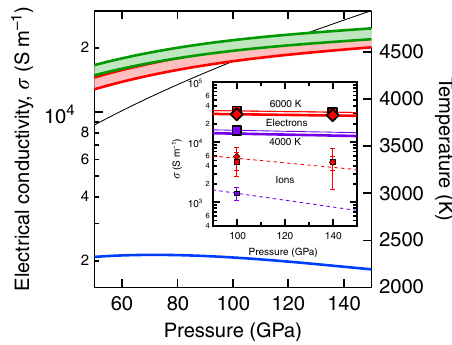
Fig. 1 Electrical conductivity. The electronic σ el (red), ionic σ ion (blue), and total σ total = σ el + σ ion (green) electrical conductivity along the magma ocean isentrope 37 (black) for low-spin (top of range shown) and high-spin (bottom of range) results. Along the magma ocean isentrope, the electrical conductivity increases with depth because the effects of increasing temperature outweigh the effects of increasing pressure. Inset. The electrical conductivity of the bulk silicate Earth liquid from our simulations, including the electronic (large symbols) and ionic (small symbols with 1 σ uncertanties) contributions at 6000 K (red) and 4000 K (purple) in spin- polarized (diamonds) and non-spin-polarized (squares) calculations. Lines are best fi ts to the form σ ¼ σ 0 T (cid:2) 1 exp (cid:2) E (cid:3) þ PV (cid:3) ð Þ = RT ½ (cid:4) for the electronic non-spin-polarized results ( σ 0 = 1.994e9 S/m, E * = 108.6 kJ/mol, V * = 0.0611 cm 3 /mol, light solid lines) and shifted uniformly downward to account for spin-polarization ( σ 0 = 1.754e9 S/m, bold solid lines), and to the ionic contribution ( σ 0 = 1.0811e9 S/m, E * = 131.0 kJ/mol, V * = 0.437 cm 3 /mol, dashed lines).